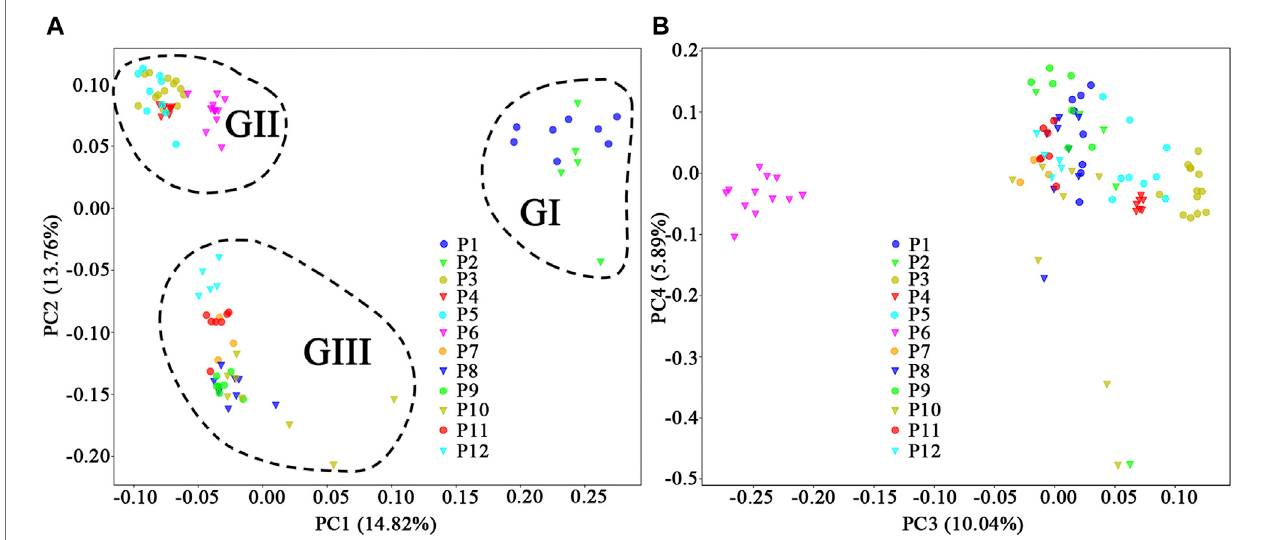
FIGURE 5 | Principal coordinates analysis of individual genotypes obtained from 12 populations of Primulina danxiaensis based on the natural dataset. (A) Plot of PC1 and PC2. (B) Plot of PC3 and PC4. P1 – P12: population ID for the 12 populations of P. danxiaensis .